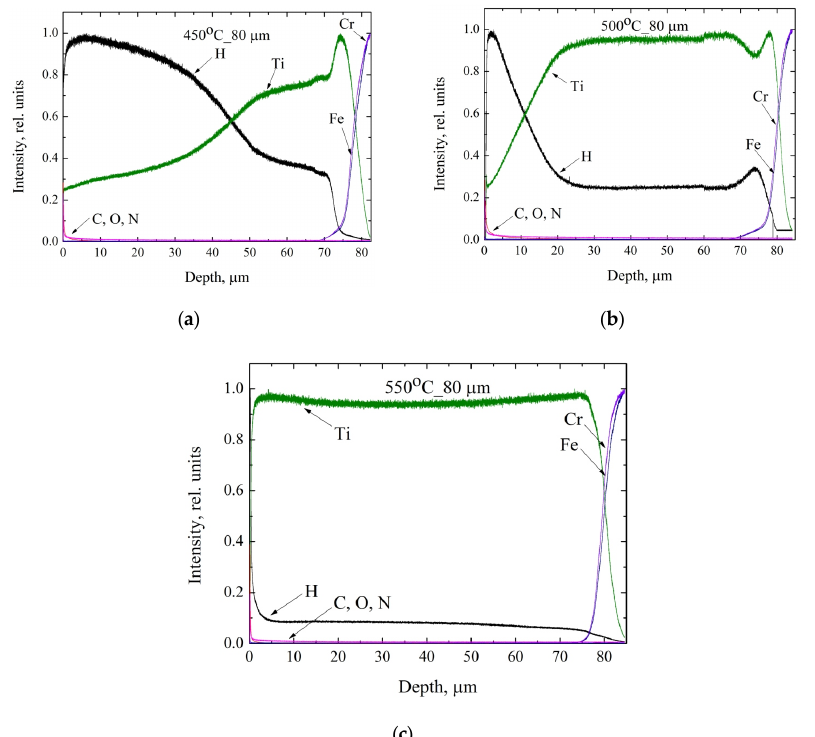
Figure 9. Distribution of elements in the 80 µm Ti coating during hydrogenation at different temperatures: 450 °C ( a ), 500 °C ( b ), and 550 °C ( c